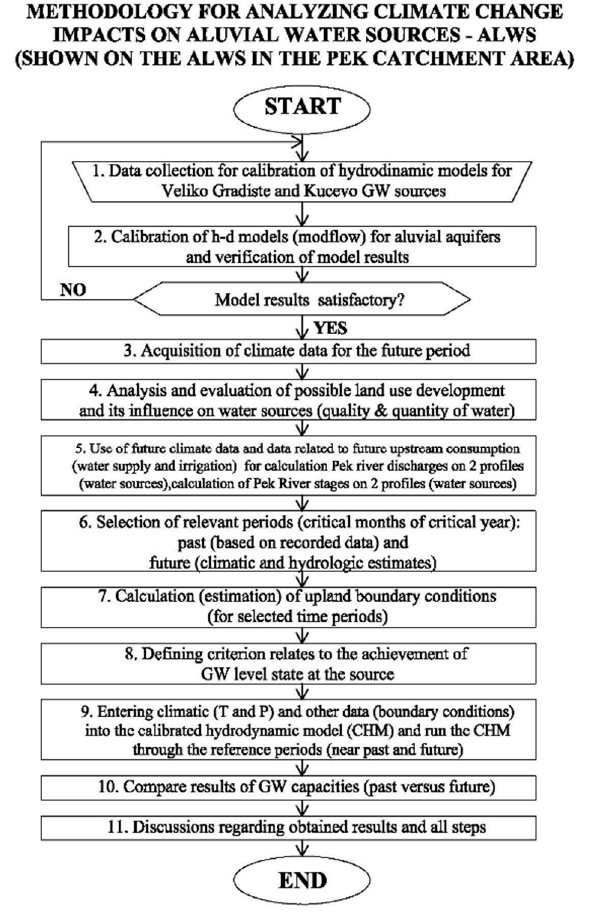
Figure 3. General